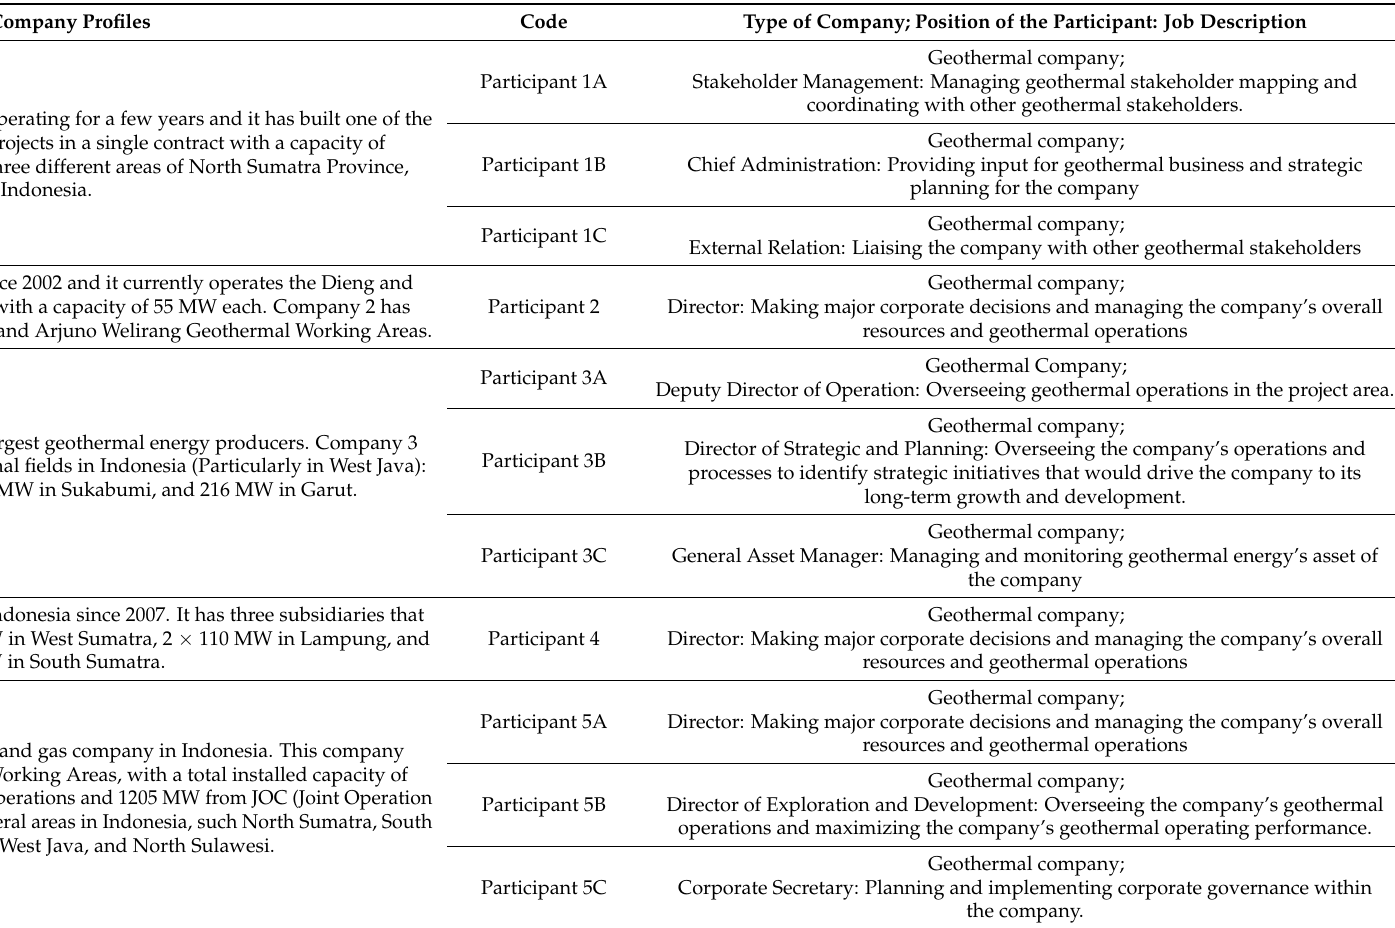
Table 1. List of the workshop participants and their brief company’s